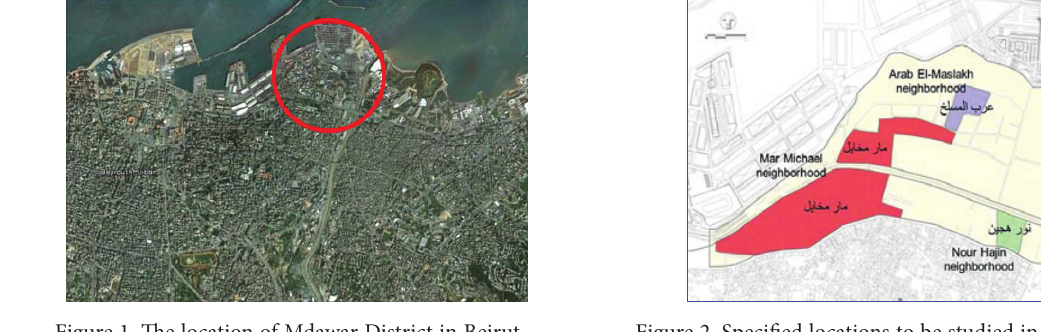
Figure 1. The location of Mdawar District in Beirut Figure 2. Specified locations to be studied in order to resolve the Social fragmentation in Mdawar